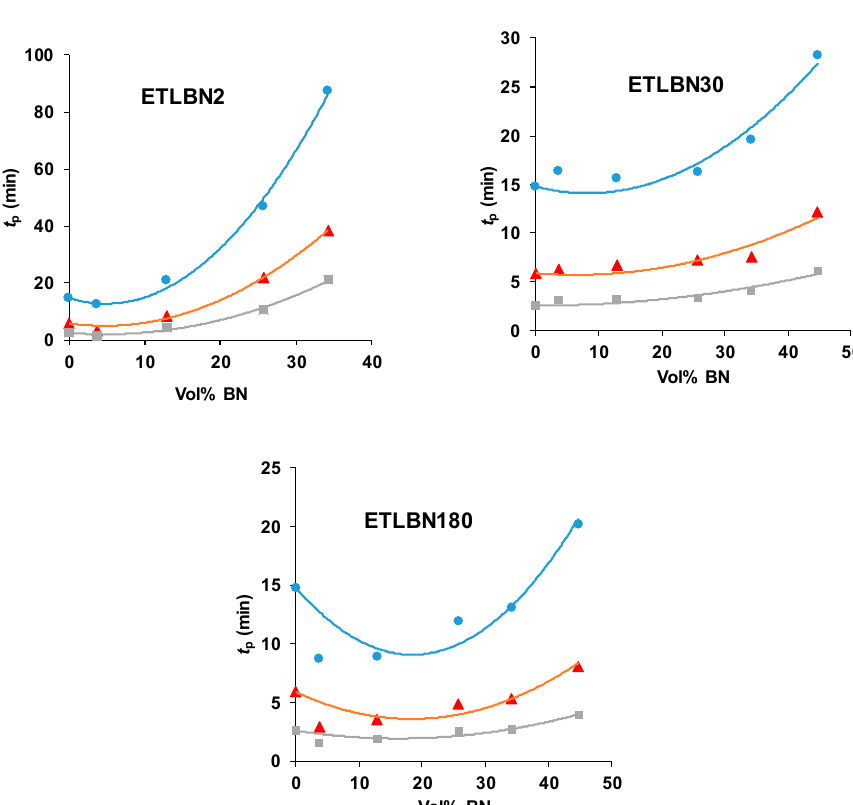
Figure 5. Time of exothermic peak during isothermal cure, t p , as a function of BN content for different platelet sizes, as indicated, and for different isothermal cure temperatures: 60 °C, blue circles; 70 °C, red triangles; 80 °C, grey squares.